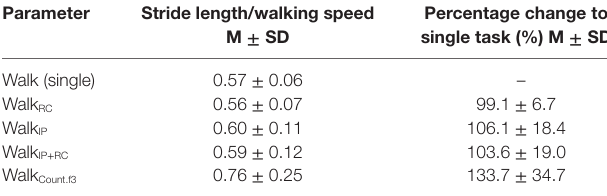
TaBle 5 | Ratio of stride length to walking speed during single and dual tasks. Parameter